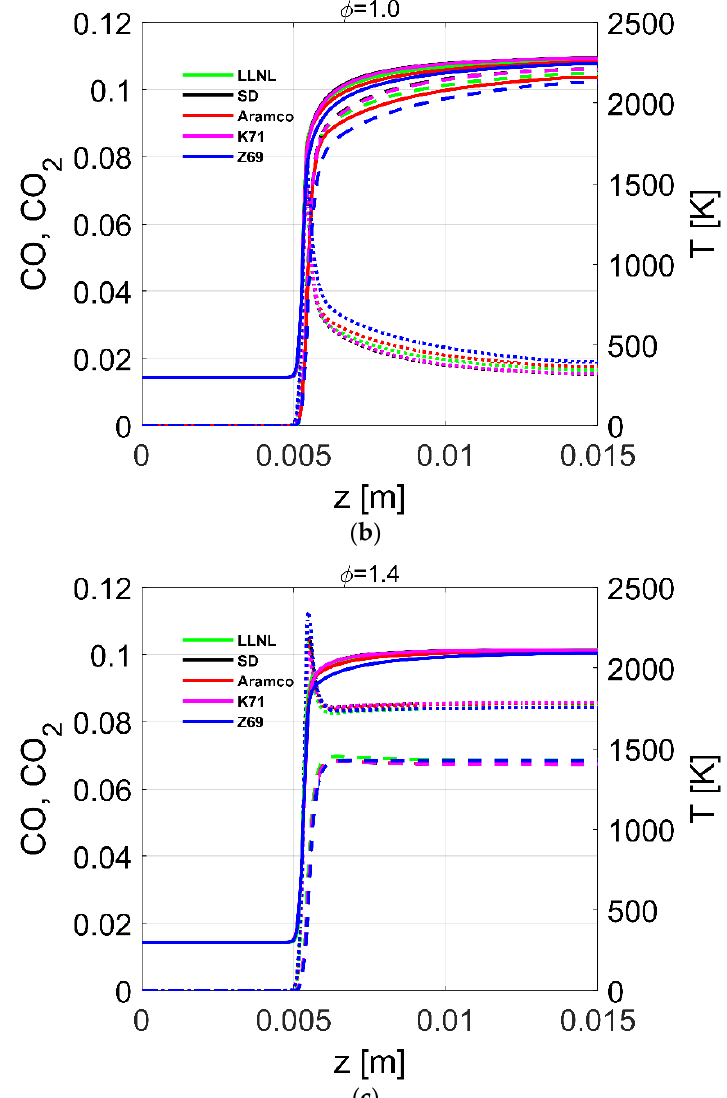
Figure 9. Flame profiles showing the flame temperature (solid line) and major species concentrations, CO 2 (dashed line) and CO (dotted line), at standard conditions of 1 atm and 300 K. Three equivalence ratios are shown with ϕ = 0.6 in ( a ), ϕ = 1.0 in ( b ) and ϕ = 1.4 in ( c ). Legend: mechanism predictions from Z69 in blue, LLNL in green [28], Aramco in red [17], K71 in magenta [32] and San Diego in black [30].